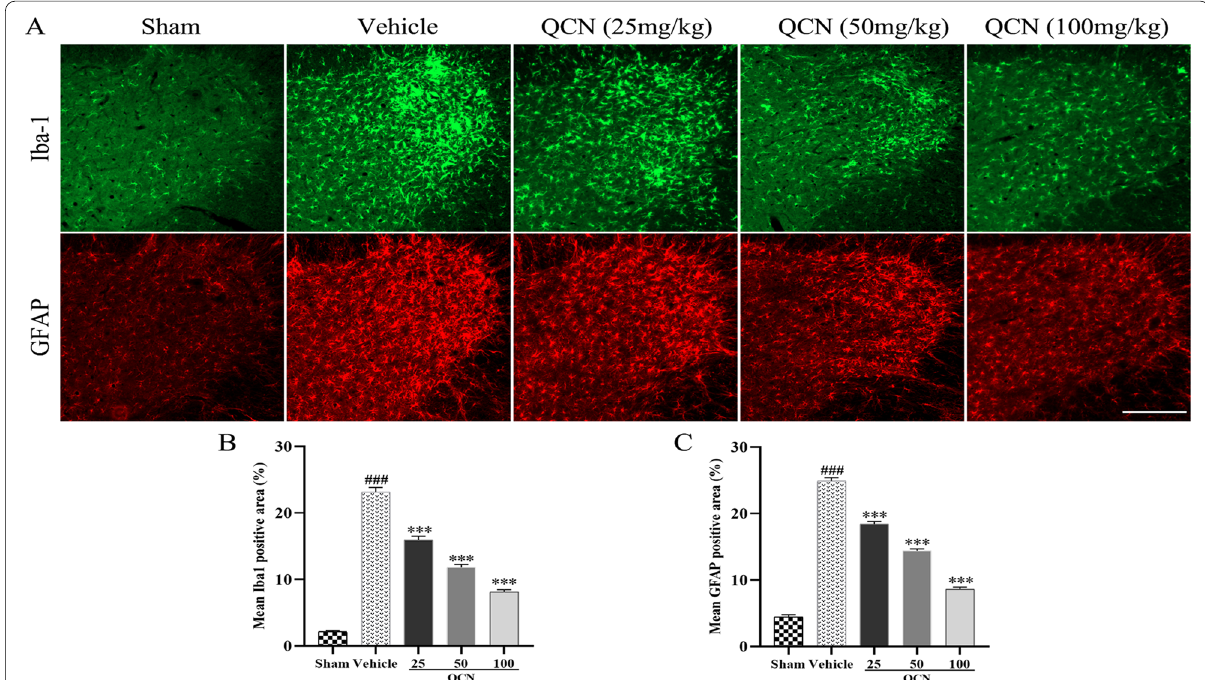
Fig. 5 Inhibitory effects of QCN on the activation of microglia and astrocytes of the BPA rats at week 8 post‑avulsion. A Representative images of Iba1 (green) and GFAP (red) staining cells in the ipsilateral C6–7 ventral spinal segments at 8 weeks post‑avulsion injury. Mean B Iba1‑immunoreactive and C GFAP‑immunopositive area in the ipsilateral C6–7 ventral spinal segments from all groups. Data are expressed as the mean SEM ( n 6). ### p < 0.001 vs the sham group; *** p < 0.001 vs the vehicle group. Scale bar 200 μm ± =